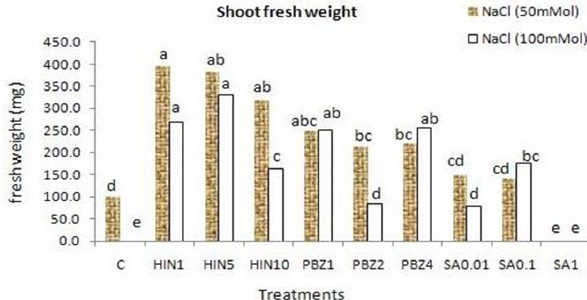
Fig. 3. Effect of hinokitiol, salicylic scid and paclobutrazol on shoot fresh weight